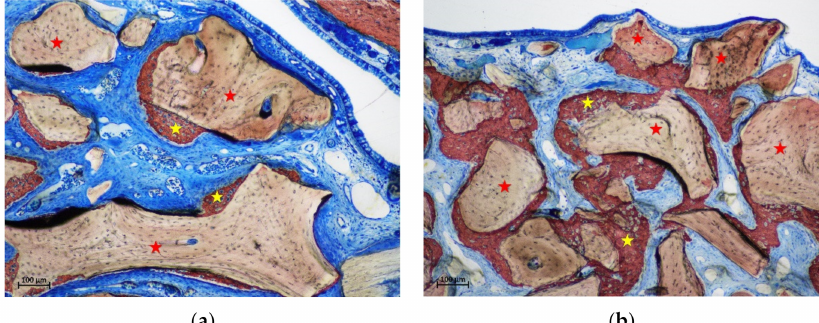
Figure 9. ( a ) photomicrograph of a ground section at the intermediate region of a test site after 4 weeks of healing. Note new bone formed on the xenograft surfaces opposite the sinus mucosa. ( b ) photomicrograph of a ground section at the middle region of a control site after 8 weeks of healing. New bone presented a continuity with that formed in the other regions of the elevated space. Stars indicate example of new bone (yellow), and xenogeneic granules (red). Stevenel’s blue and alizarin red stain.